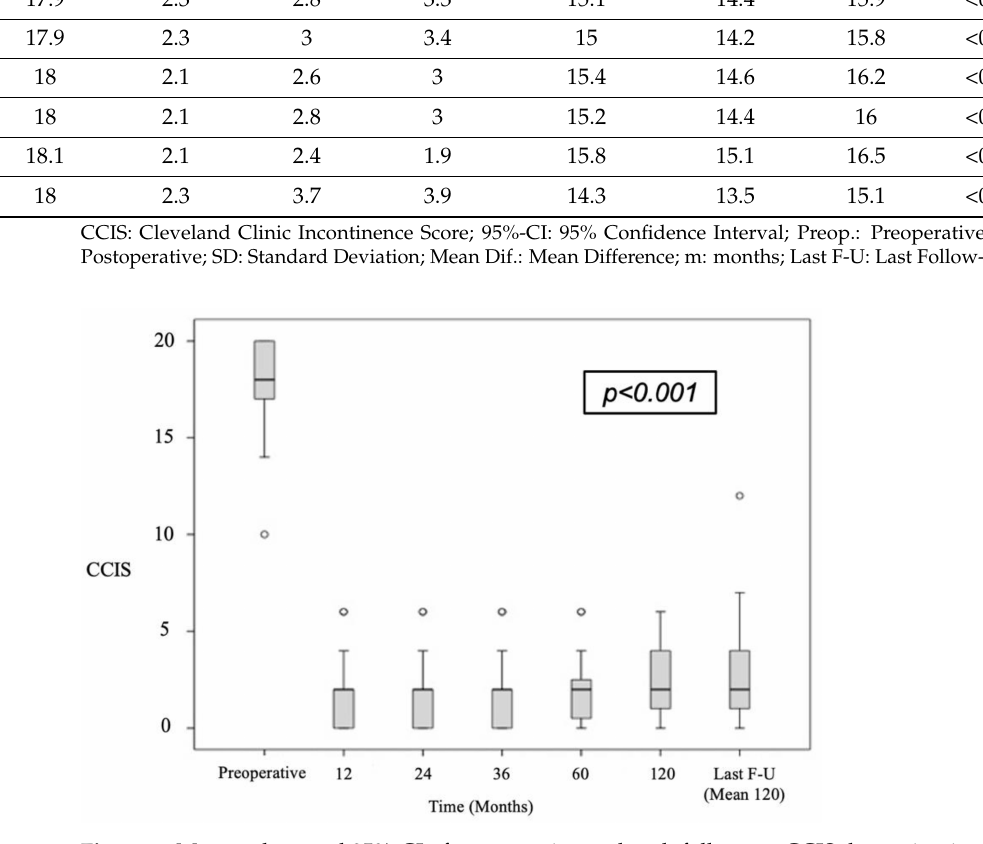
Figure 2. Mean values and 95%-CI of preoperative and each follow-up CCIS